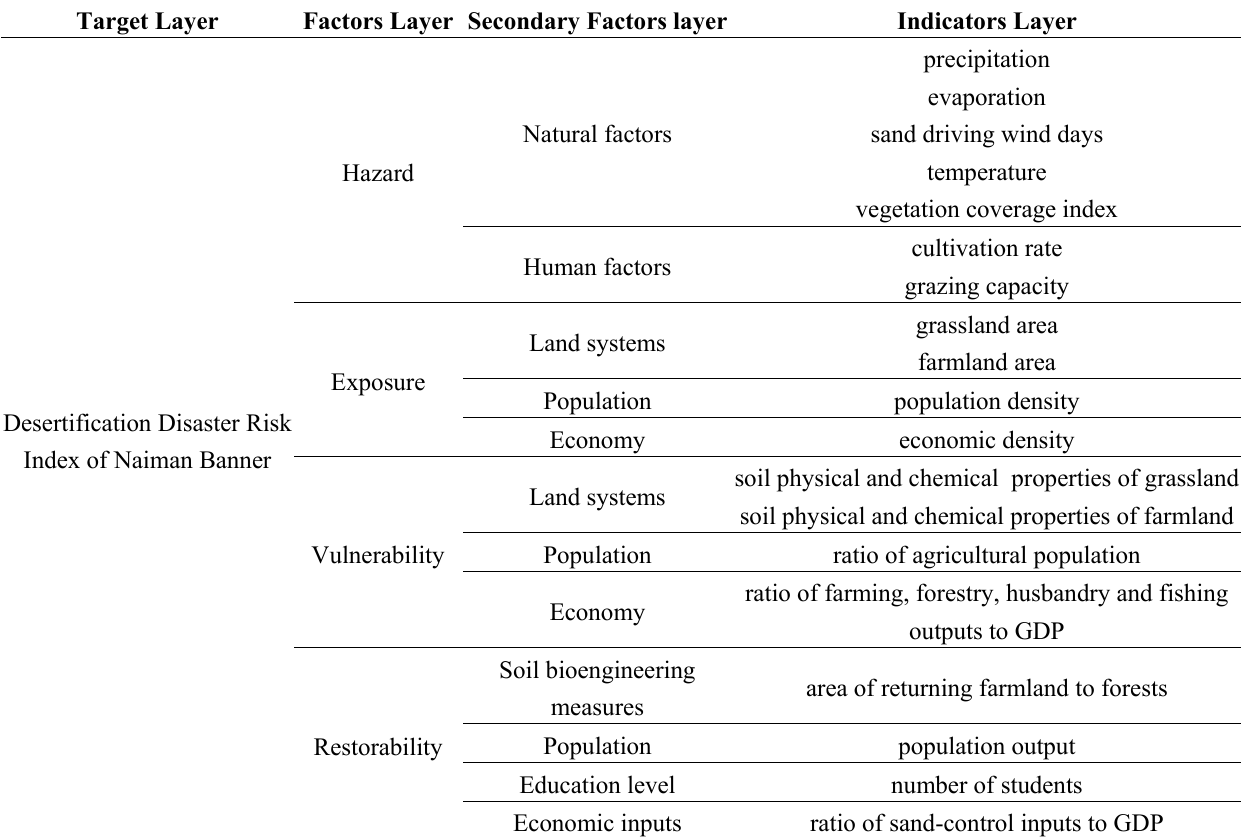
Table 1. Desertification disaster risk assessment